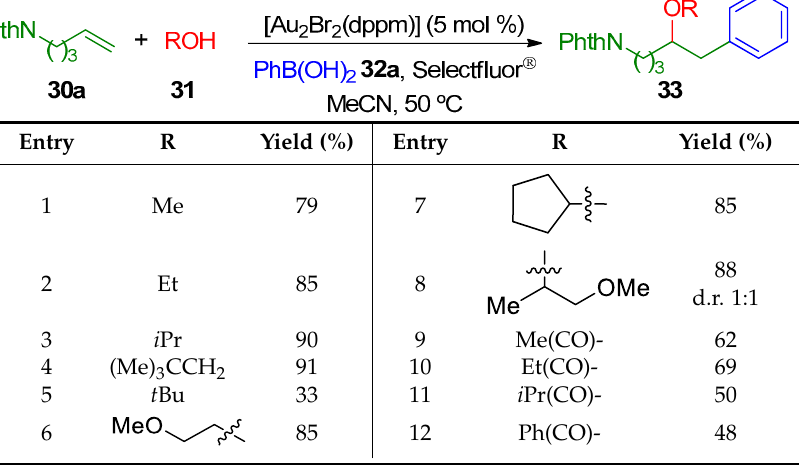
Table 1. Alkoxy- and acyloxyarylation using different alcohols 31 .